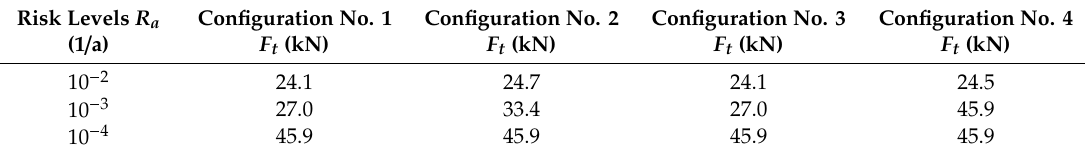
Figure 12. Annual frequency of exceeding actual values of force F t at lookout point A for different PSPA configurations. Table 3. Values of force F t for chosen risk levels and four different PSPA configurations at lookout point A.